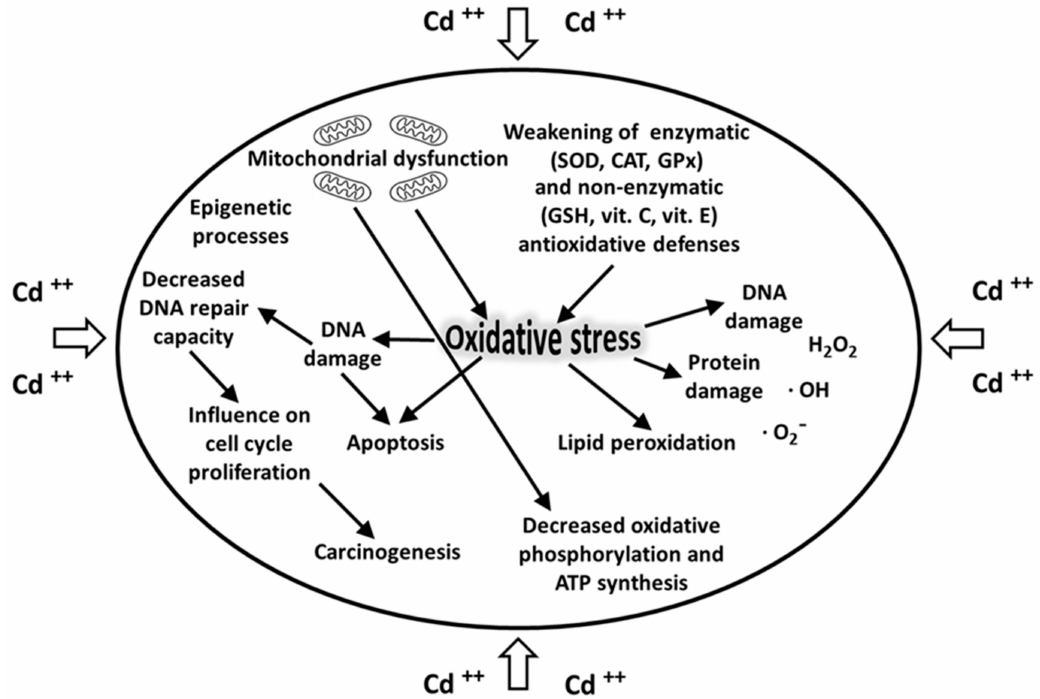
Figure 3. Cadmium acts on mitochondria, awakening the enzymatic and non-enzymatic antioxidative defenses. Cadmium induces oxidative stress, to resulting in the damage of proteins, lipids, and DNA. Cadmium decreases the activity of DNA repair enzymes, influencing cell cycle proliferation and stimulating